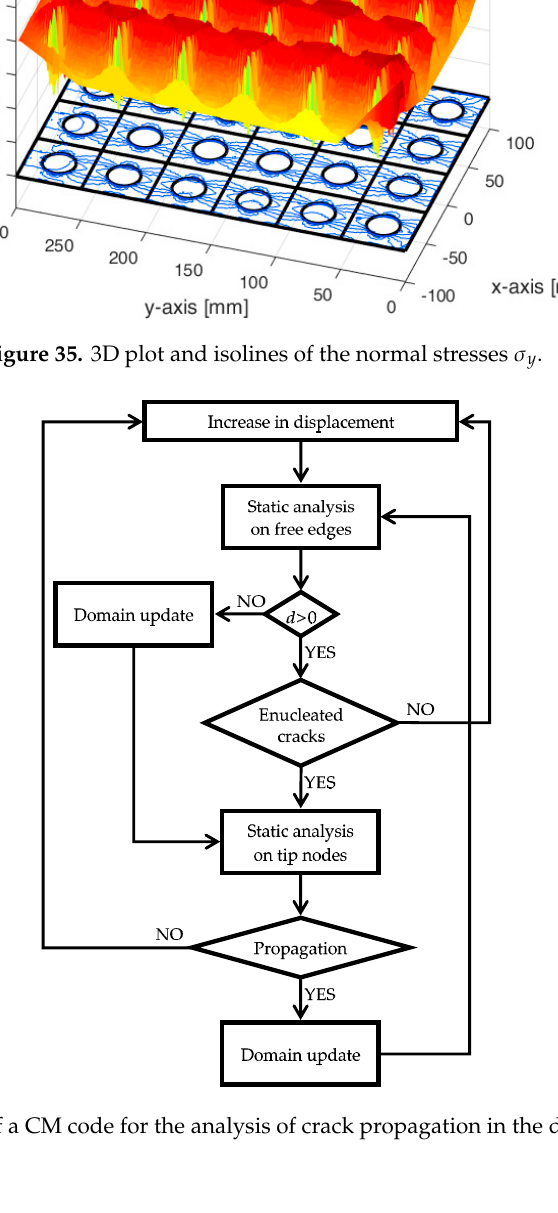
Figure 36. Flow chart of a CM code for the analysis of crack propagation in the displacement control.